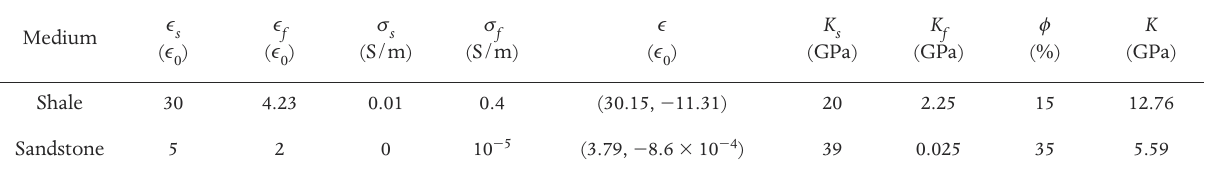
Table 1. Properties. A = 3; ~ = 100 MHz.